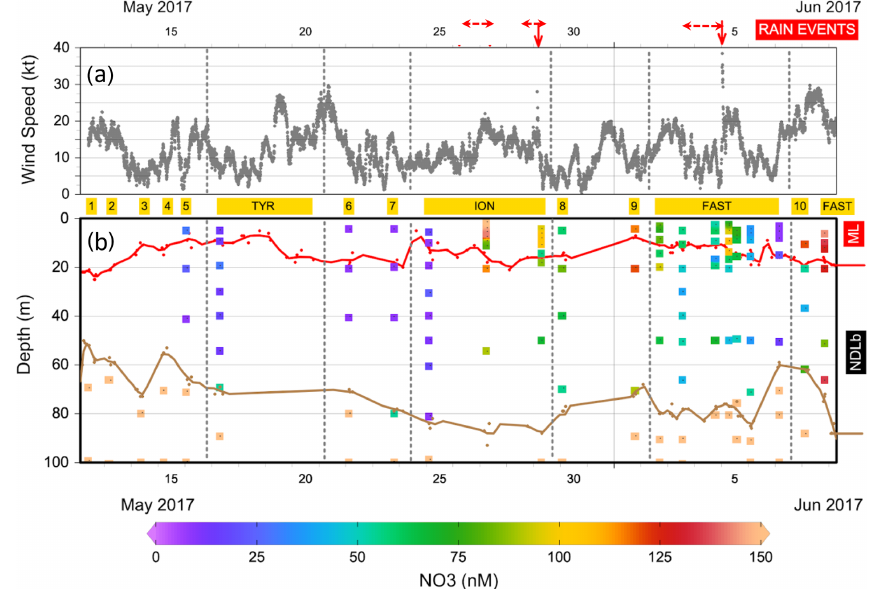
Figure 3. (a) Evolution of the wind speed during the PEACETIME cruise. The stations are indicated in yellow and dates in black. Vertical dashed lines delineate the beginning and the end of the ship’s deployment at TYR, ION and FAST. The two rain events collected on board are indicated by the solid vertical red arrows and surrounding observed rain events by horizontal dashed red arrows. (b) Distribution of nitrate (NO3) in the upper 100m of the water column. The MLD (in red) and nitracline (in brown) are